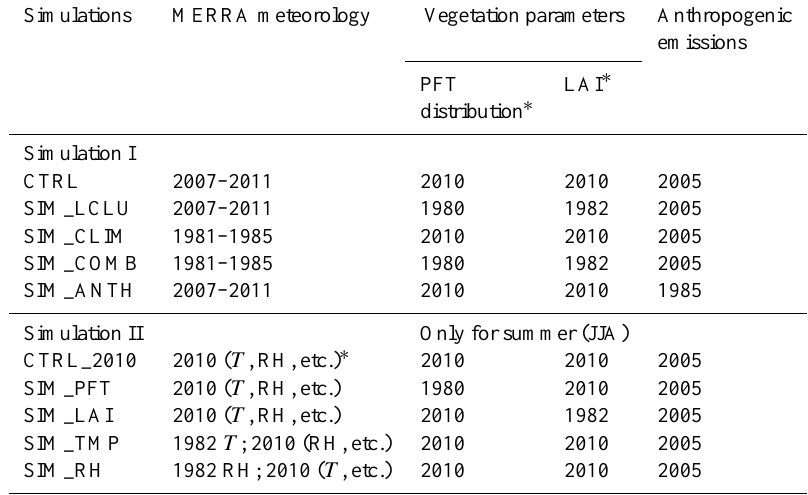
Table 1. Summary of the simulations in this